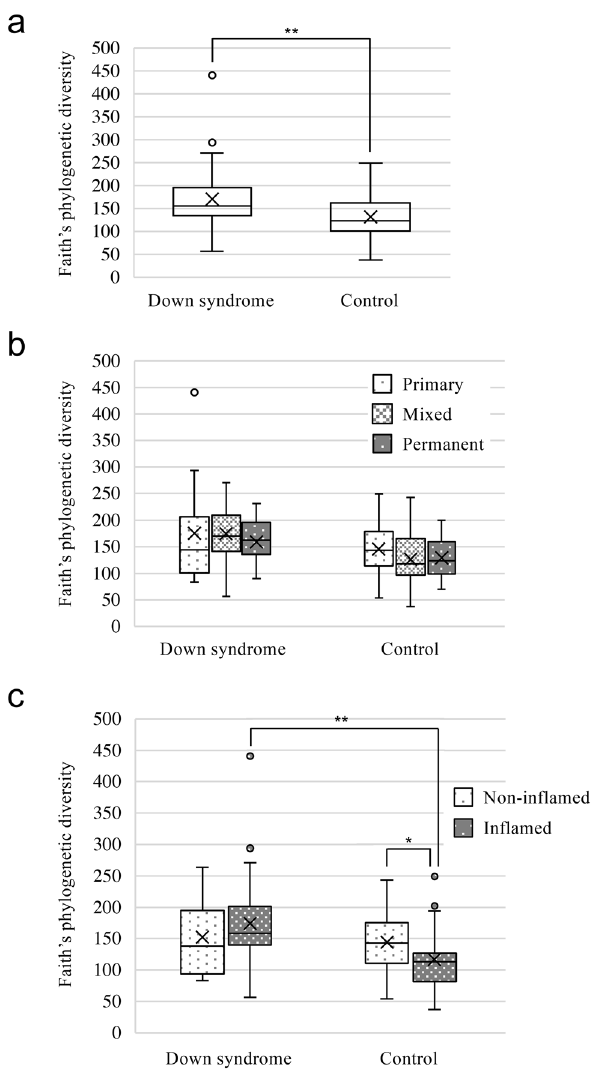
Figure 2. Faith’s phylogenetic diversity analysis of α-diversity in the Down syndrome and the control groups. Comparisons between the two groups were made for ( a ) all participants, ( b ) dentition stage, and ( c ) gingival inflammation status. Whiskers indicate maximum and minimum values, boxes indicate the interquartile range, X indicates the mean value, and circles indicate outliers. * P < 0.05 and ** P < 0.01 by the Kruskal–Wallis test